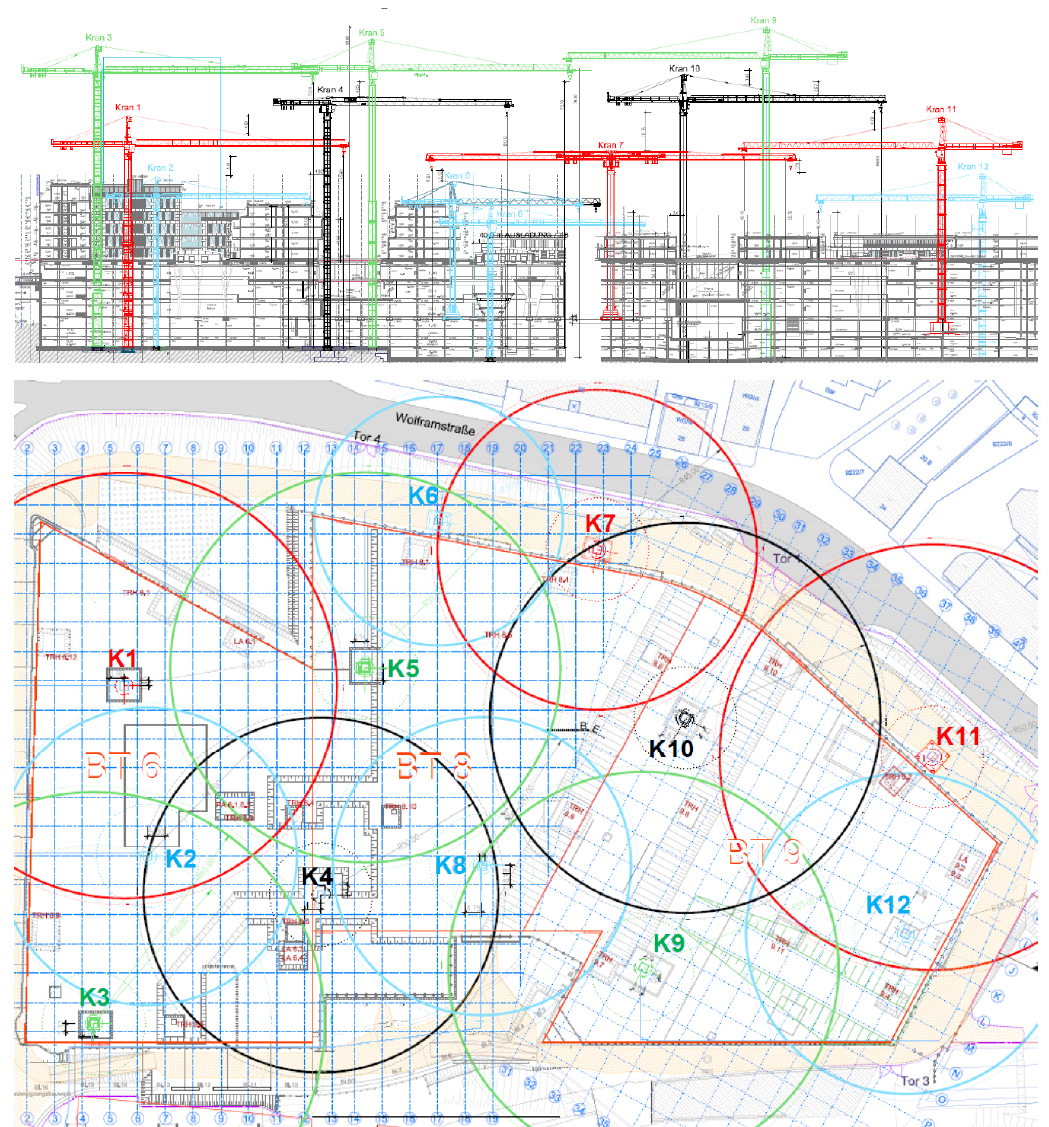
Figure 1. Multi ‐ crane site (12 tower cranes): top–elevation; bottom–plan. Figure 1. Multi-crane site (12 tower cranes): top–elevation;